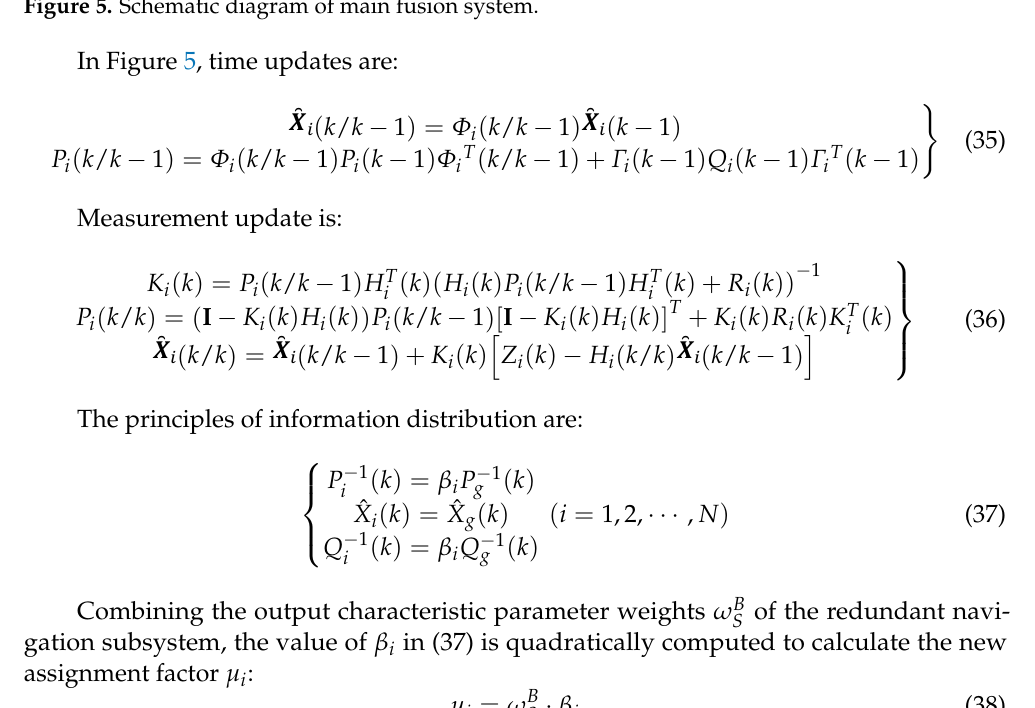
Figure 5. Schematic diagram of main fusion system.